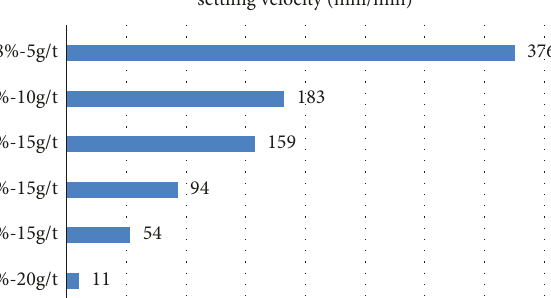
Figure 4: Settlement curve.